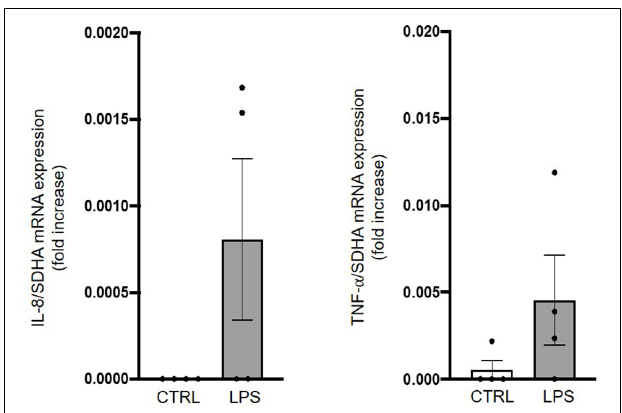
FIGURE 6 | Assessment of brainstem inflammation following systemic lipopolysaccharide injection. Quantitative RT-PCRs in whole brainstem tissue show an increased IL-8 and TNF- α mRNA expression in LPS-injected lambs compared to control lambs. Results are expressed as fold increase compared to an endogenous control (the housekeeping gene SDHA) and presented as mean ± SD ( n = 4 lambs per